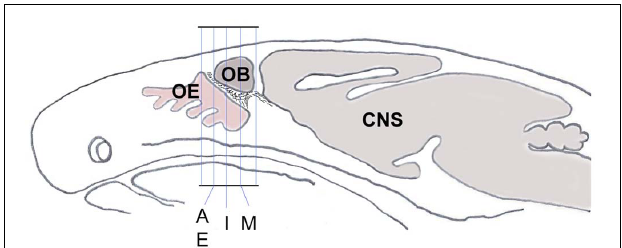
FIGURE 1 | Schematic sagittal section through a mouse head shows the orientation and planes of tissue sections from Figures 2A–P , 3C–F . Sections within those planes were used for demonstration of double-immunolabeling and for cell counting. CNS, central nervous system; OB, olfactory bulb; OE, olfactory